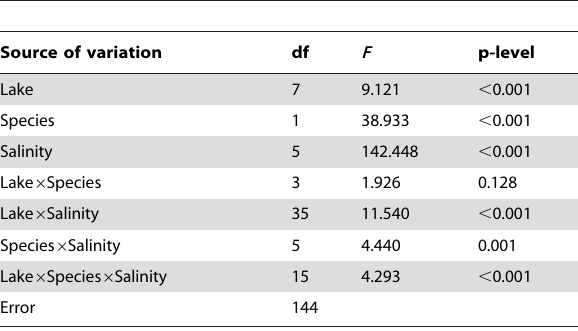
Table 2. ANOVA results of the effects of lake, species and salinity on the clonal growth rate ( r